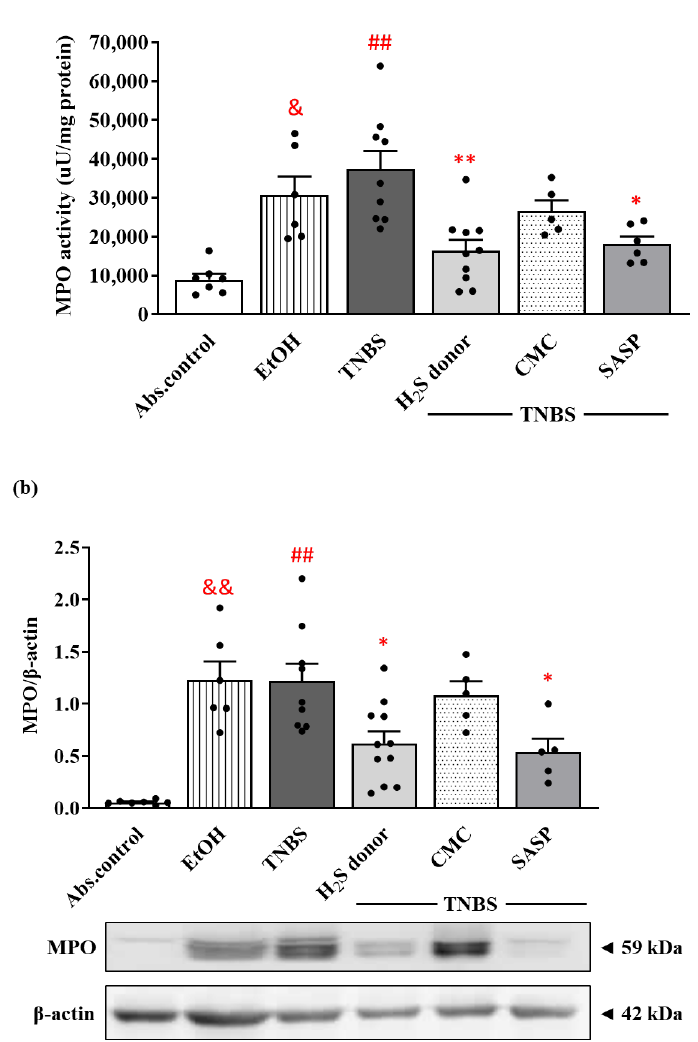
Figure 4. Alterations of the colonic myeloperoxidase (MPO) enzyme activity ( a ) and expression ( b ) following H 2 S donor administration in TNBS-induced rat colitis. Absolute control (no treatment); EtOH (50% ethanol, the solvent of TNBS); TNBS (2,4,6-trinitrobenzenesulfonic acid enema); H 2 S donor (TNBS + 18.75 μM/kg/day Lawesson’s reagent); CMC (TNBS + 0.5% carboxymethylcellulose, the vehicle of Lawesson’s reagent); SASP (TNBS + 50 mg/kg/day sulfasalazine, as a positive control). Results are presented as mean + S.E.M.; n = 5 – 11/group; one-way ANOVA, Holm – Sidak post hoc test, ## p < 0.001 absolute control vs. TNBS; * p < 0.05, ** p < 0.001 TNBS vs. TNBS + treatments; & p < 0.05, && p < 0.001 absolute control vs. EtOH. The expression of HMGB1 was also detected using the Western blot technique. The colonic HMGB1 levels showed a statistically significant increase in the TNBS group com-